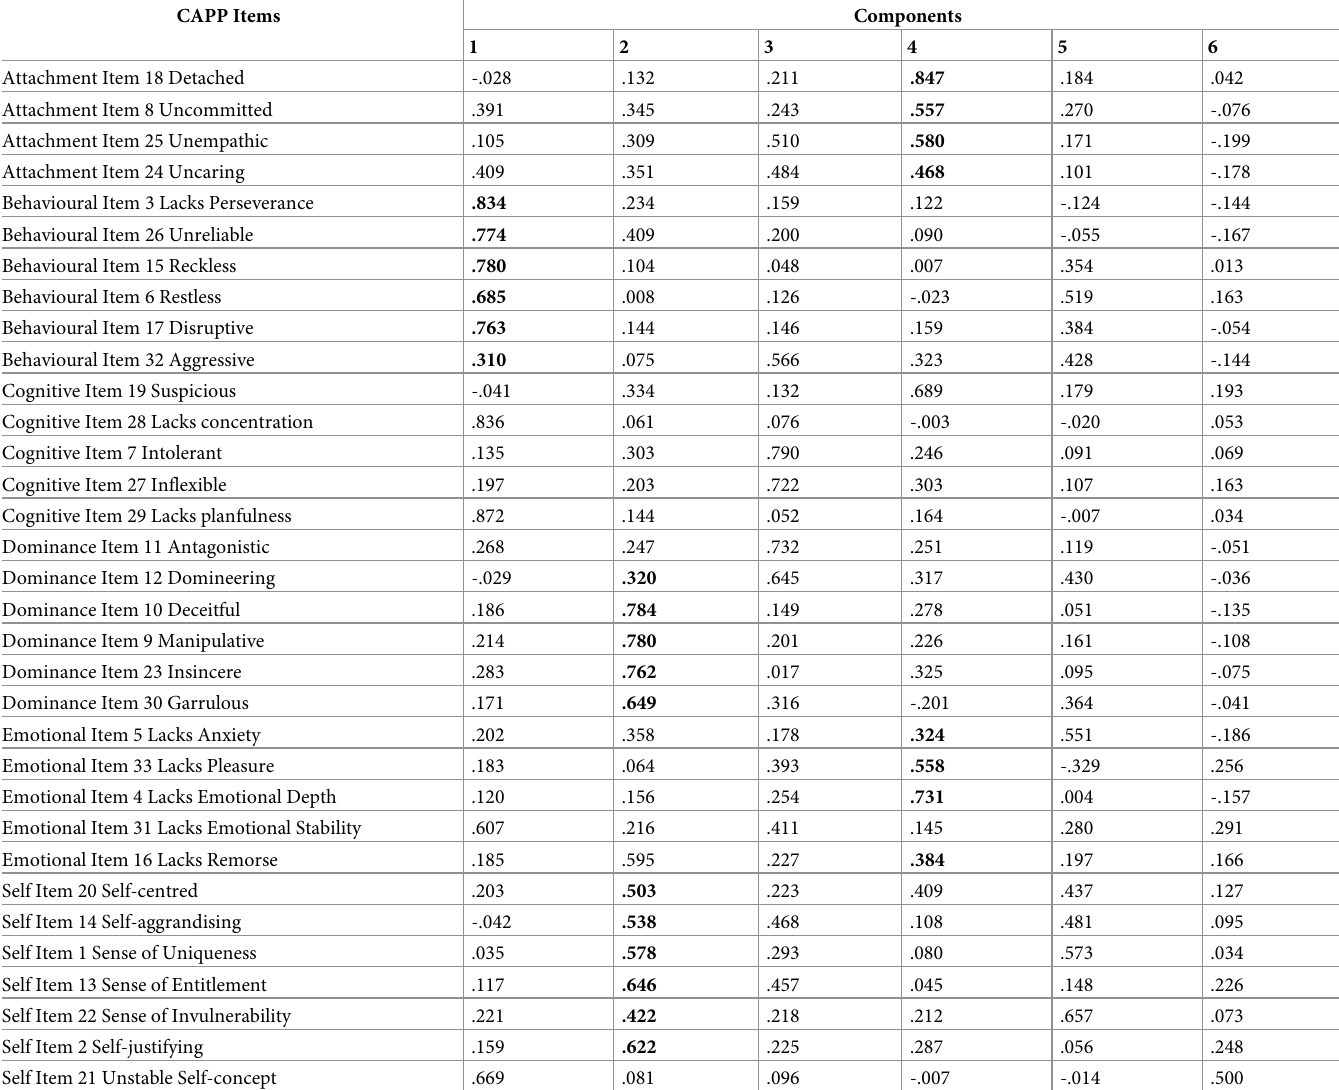
Table 9. CAPP rotated components